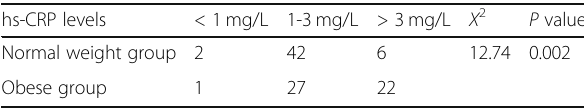
Table 4 hs-CRP levels in normal weight and obese children hs-CRP